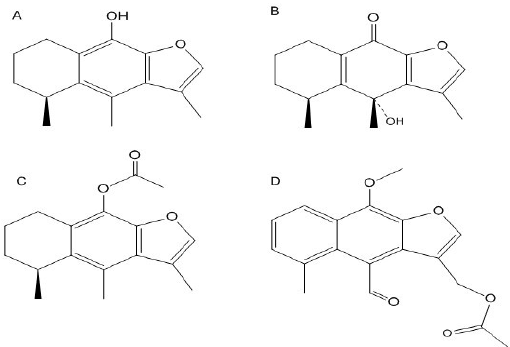
Figure 1. Chemical structures of cacalolides from two species of matarique ( P. decompositum and P.